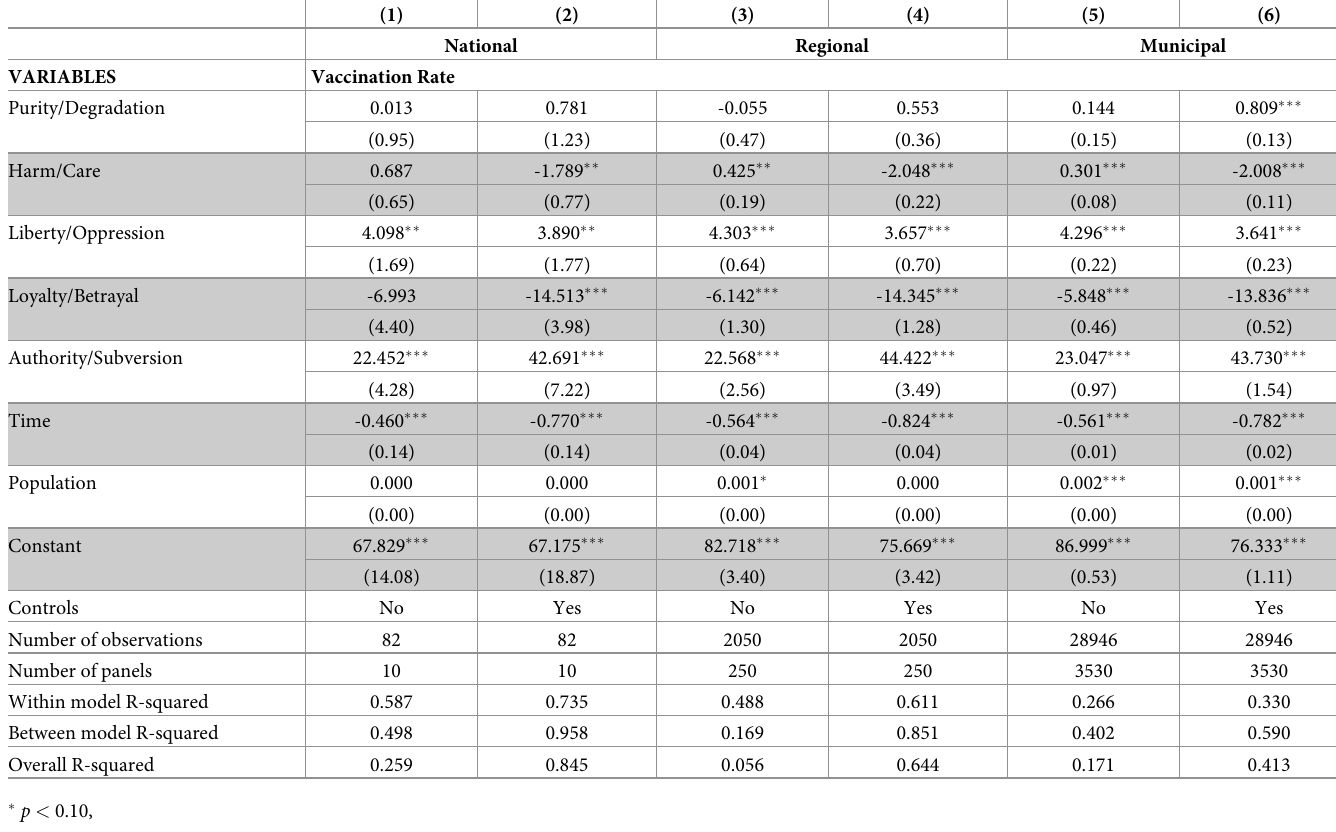
Table 5. Results of OLS fixed-effects models regressing the vaccination rate for vaccinations of the Dutch NIP on the MFT dimension loading from the associated information brochures and controls. We analyse this for data reported at the national, regional and municipal